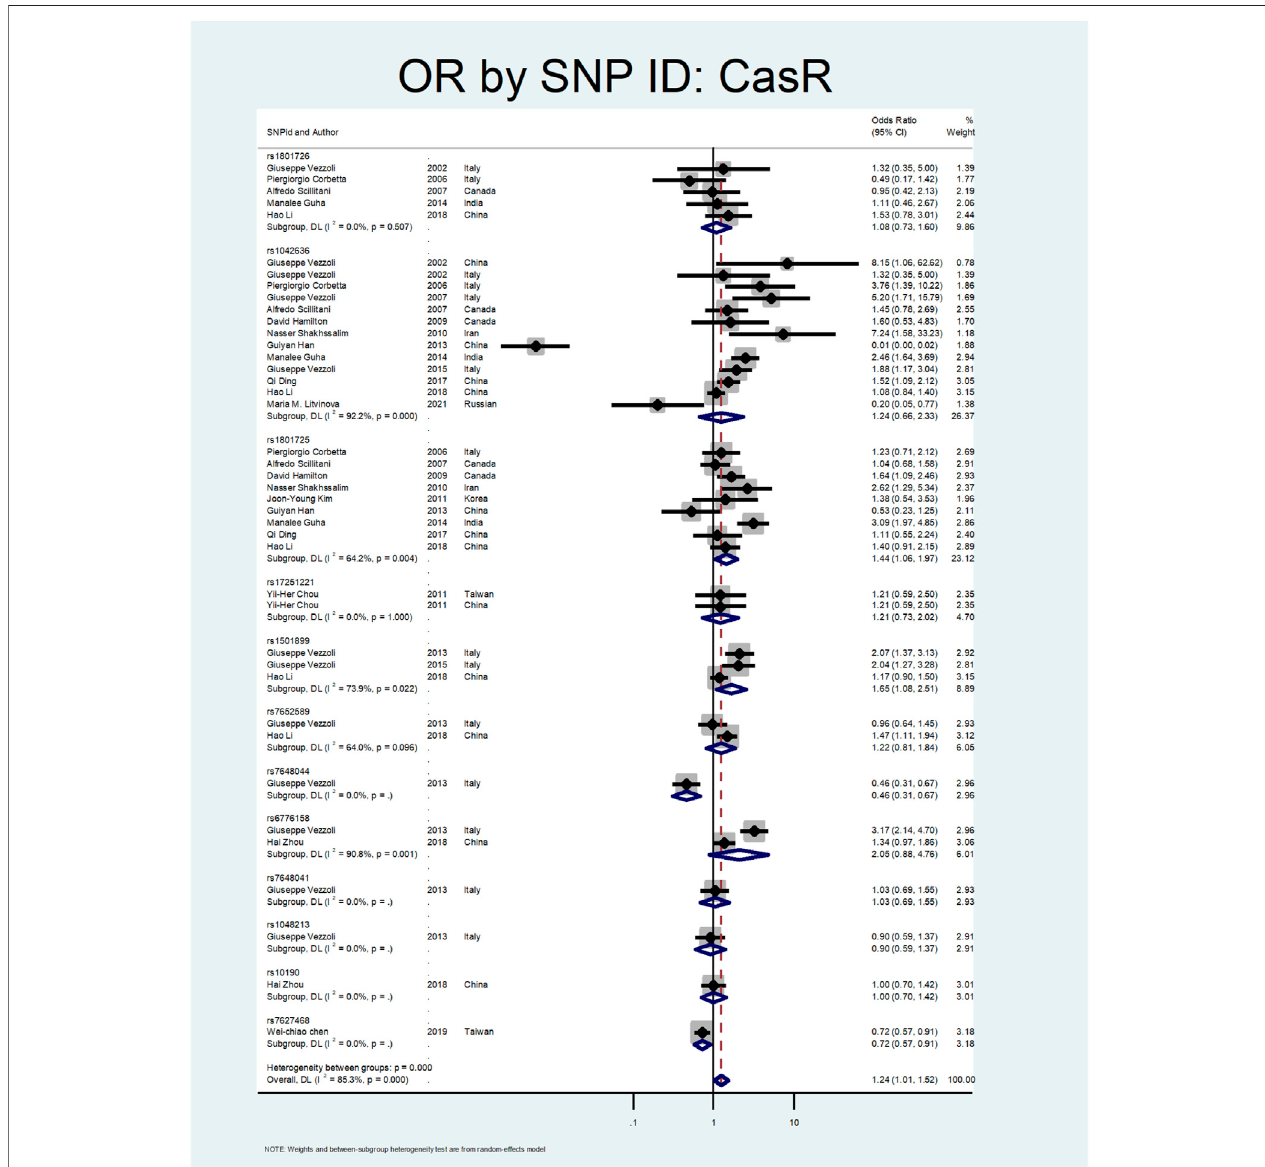
FIGURE 7 | Subgroup analysis for CASR, by SNP